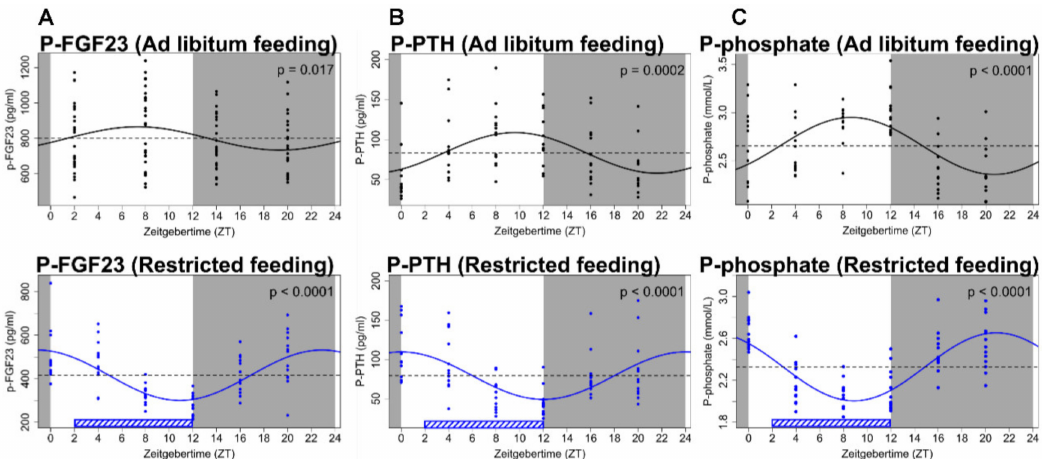
Figure 2. Circadian rhythm of FGF23 and mineral parameters. ( A ) Plasma levels of FGF23 show significant diurnal variation. Phase of fluctuation was complete reversed by feeding restricted to the inactive period (lower diagram). ( B , C ) Parathyroid hormone (PTH) and phosphate levels varied around the clock. Their acrophase and nadir were consistently shifted to the opposite value by the restricted feeding intervention. Data are fitted by cosinor regression and resulting p -values are shown, p < 0.05 is considered significant. Grey areas indicate dark period and white areas indicate light